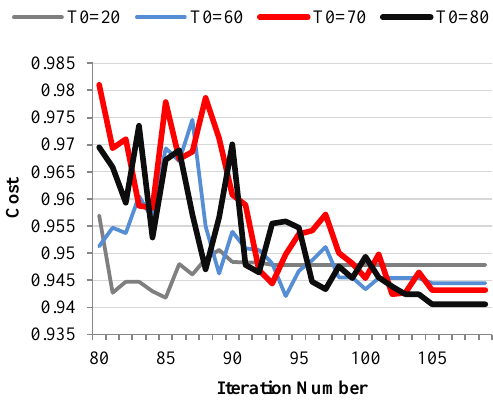
Figure 1. Changing the value of the Cost function during iterations of the algorithm for various values of T 0 .